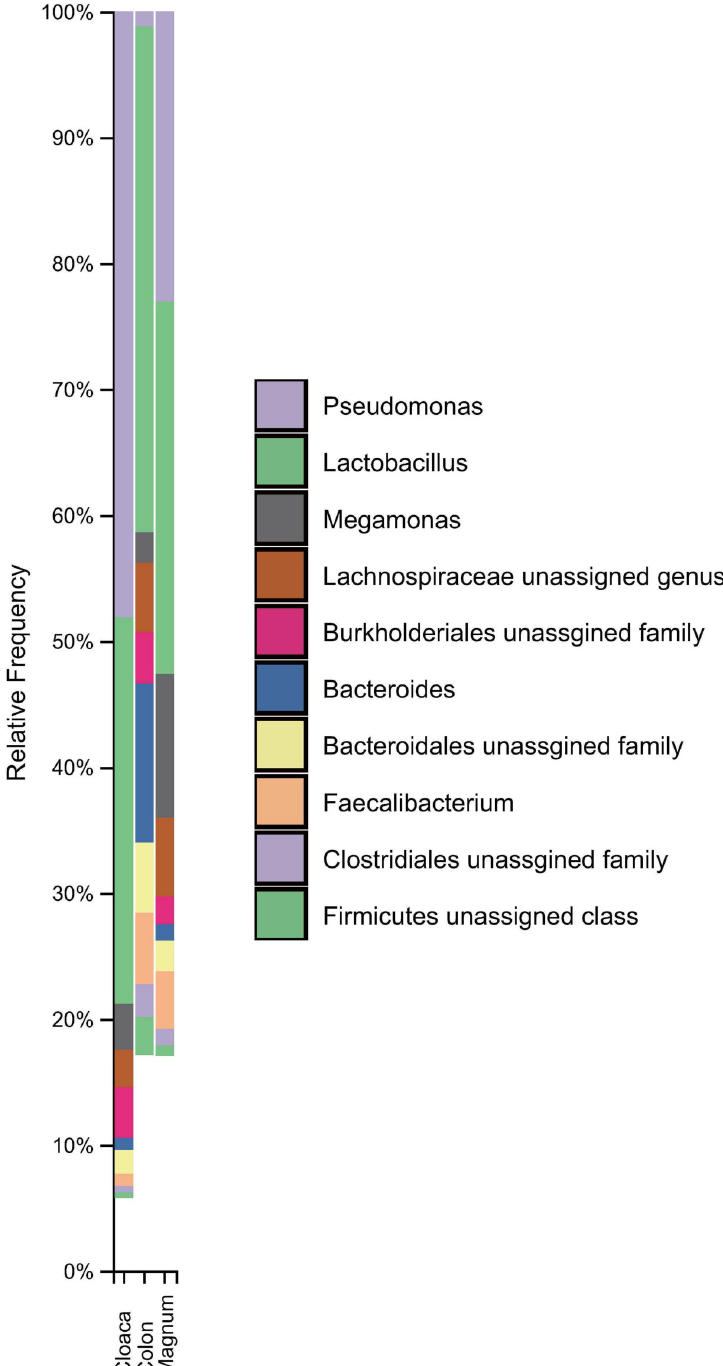
Fig 4. Relative frequency of ten of the most abundant common taxa among all groups at the genus level. Ten of the most abundant taxa, classified by different colors, are shown. Each bar indicates the relative frequencies of ten of the most abundant common taxa among all groups at genus